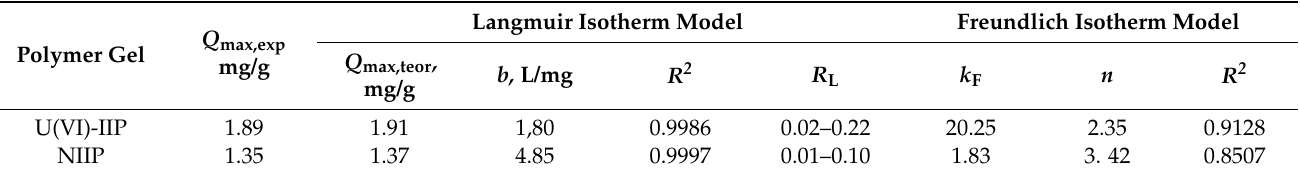
Figure 5. Effect of initial concentration of U(VI) on adsorption capacity of U(VI)-IIP and NIIP (pH 7; contact time = 30 min; temperature 298 K, three parallel experiments). Table 2. Experimental adsorption capacities, Langmuir and Freundlich isotherm parameters obtained by linear fitting for the U(VI)-IIP and NIIP at temperature 298